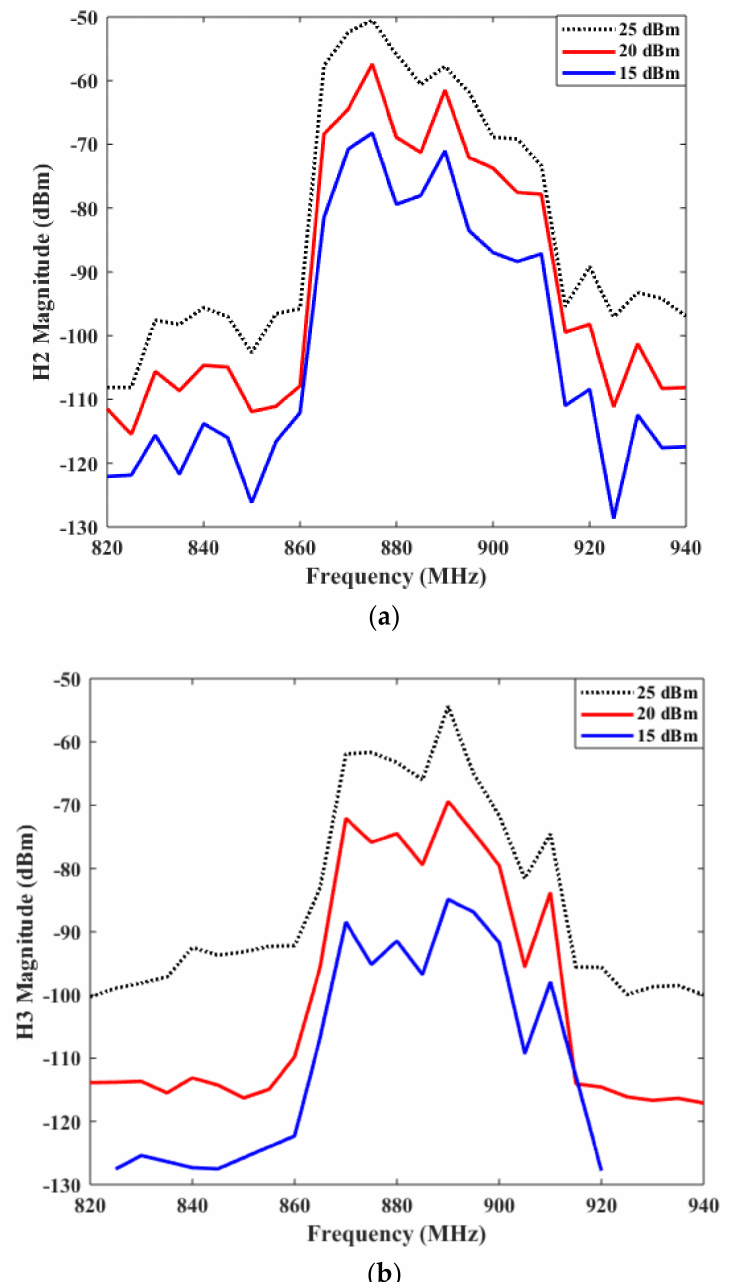
Figure 7. The measured harmonic nonlinear characteristics of Band 5 SAW filter. ( a ) The second harmonic response H2 ( b ) The third harmonic response